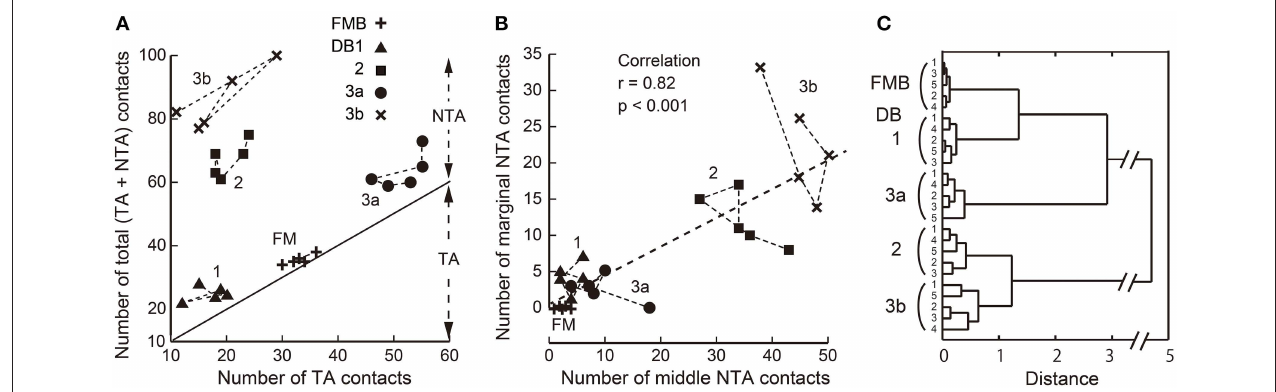
FIGURE 7 | Scatter plots of TA, middle NTA, and marginal NTA basal contacts and their clustering among the five OFF bipolar cell types. (A) Relationship between the total number of basal contacts and the number of TA contacts per cell. The slope line indicates the TA component of a total (TA + NTA) along the ordinate. (B) Numbers of marginal and middle NTA contacts are strongly correlated for the entire OFF bipolar cell population. (C) Dendrogram of cluster analysis (Ward’s method) of 25 OFF bipolar cells using the four variables plotted in (A,B) . Five clusters are differentiated.